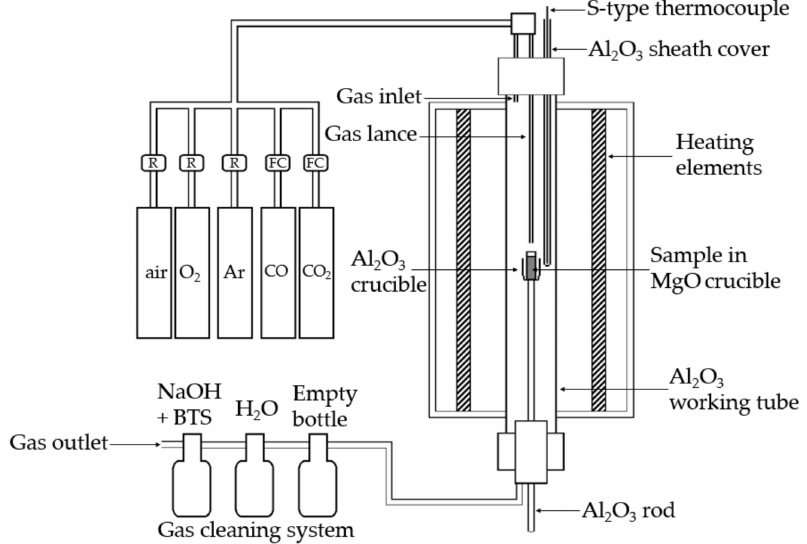
Figure 1. Schematic of the experimental arrangement including the vertical tube furnace, gas train, sample, and gas cleaning system. R = rotameter, FC = mass flow controller, BTS = bromothymol